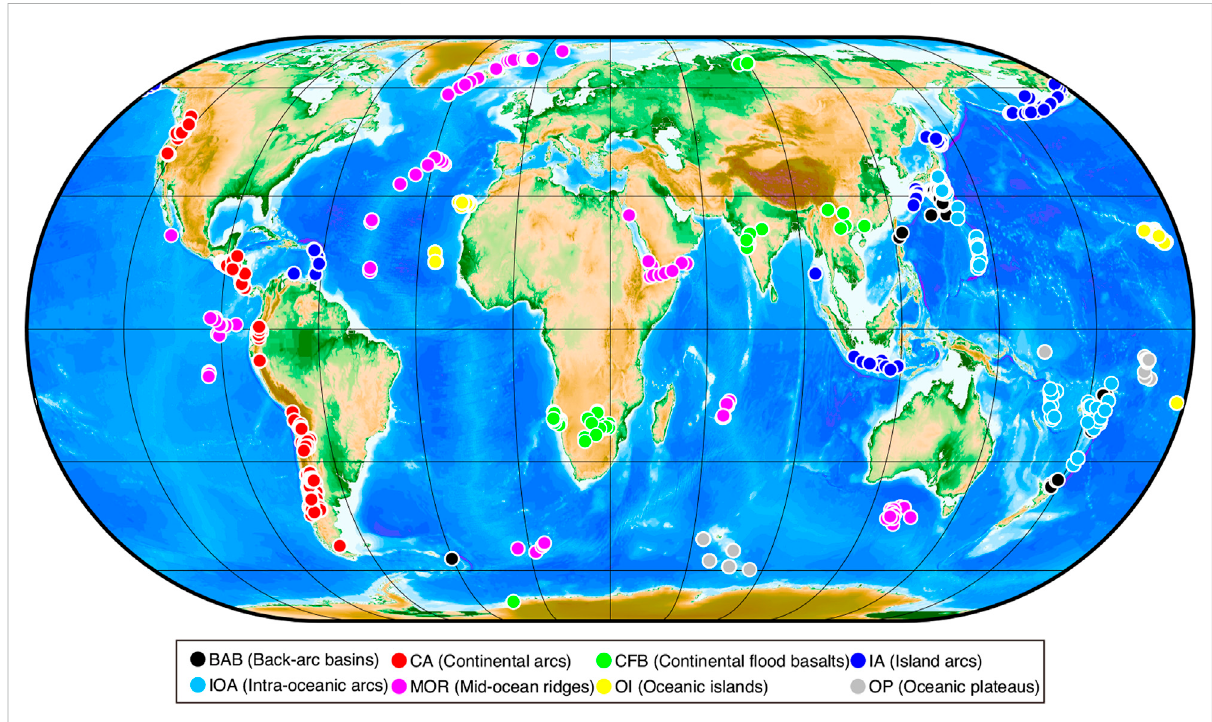
FIGURE 1 Map showing the locations of samples used in this study. Topographic data are from TerrainBase (National Geophysical Data Center/NESDIS/ NOAA/U.S. Department of Commerce,